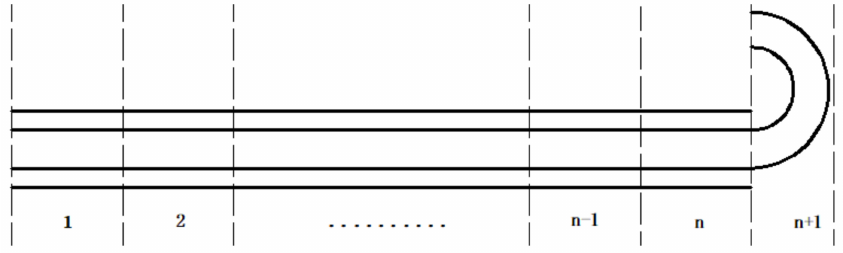
Figure 12. Dividing the total length of a tube into n + 1 tiny